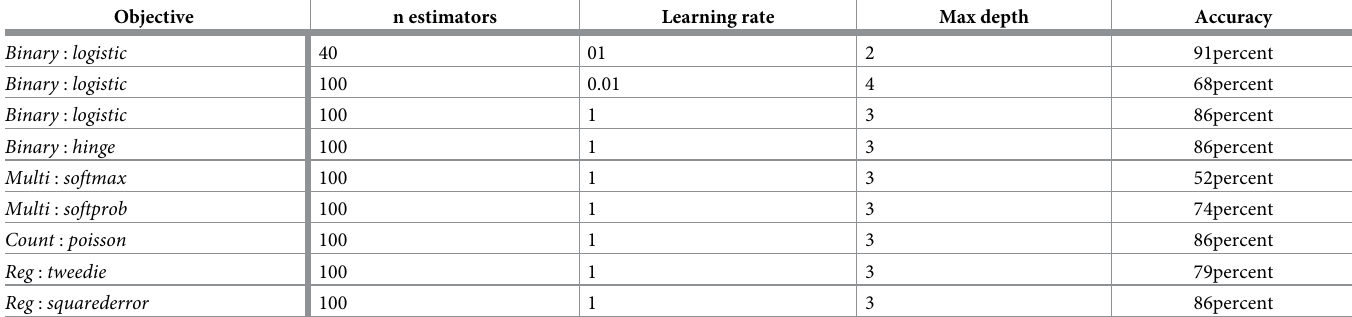
Table 5. XG Boost results after parameters tuning.